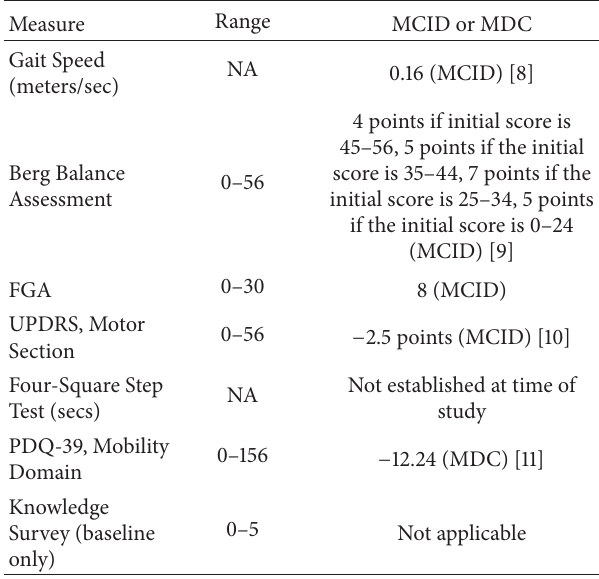
Table3:Outcomemeasures(completedatbaseline,afterLSVTBIG, and 3 months after LSVT